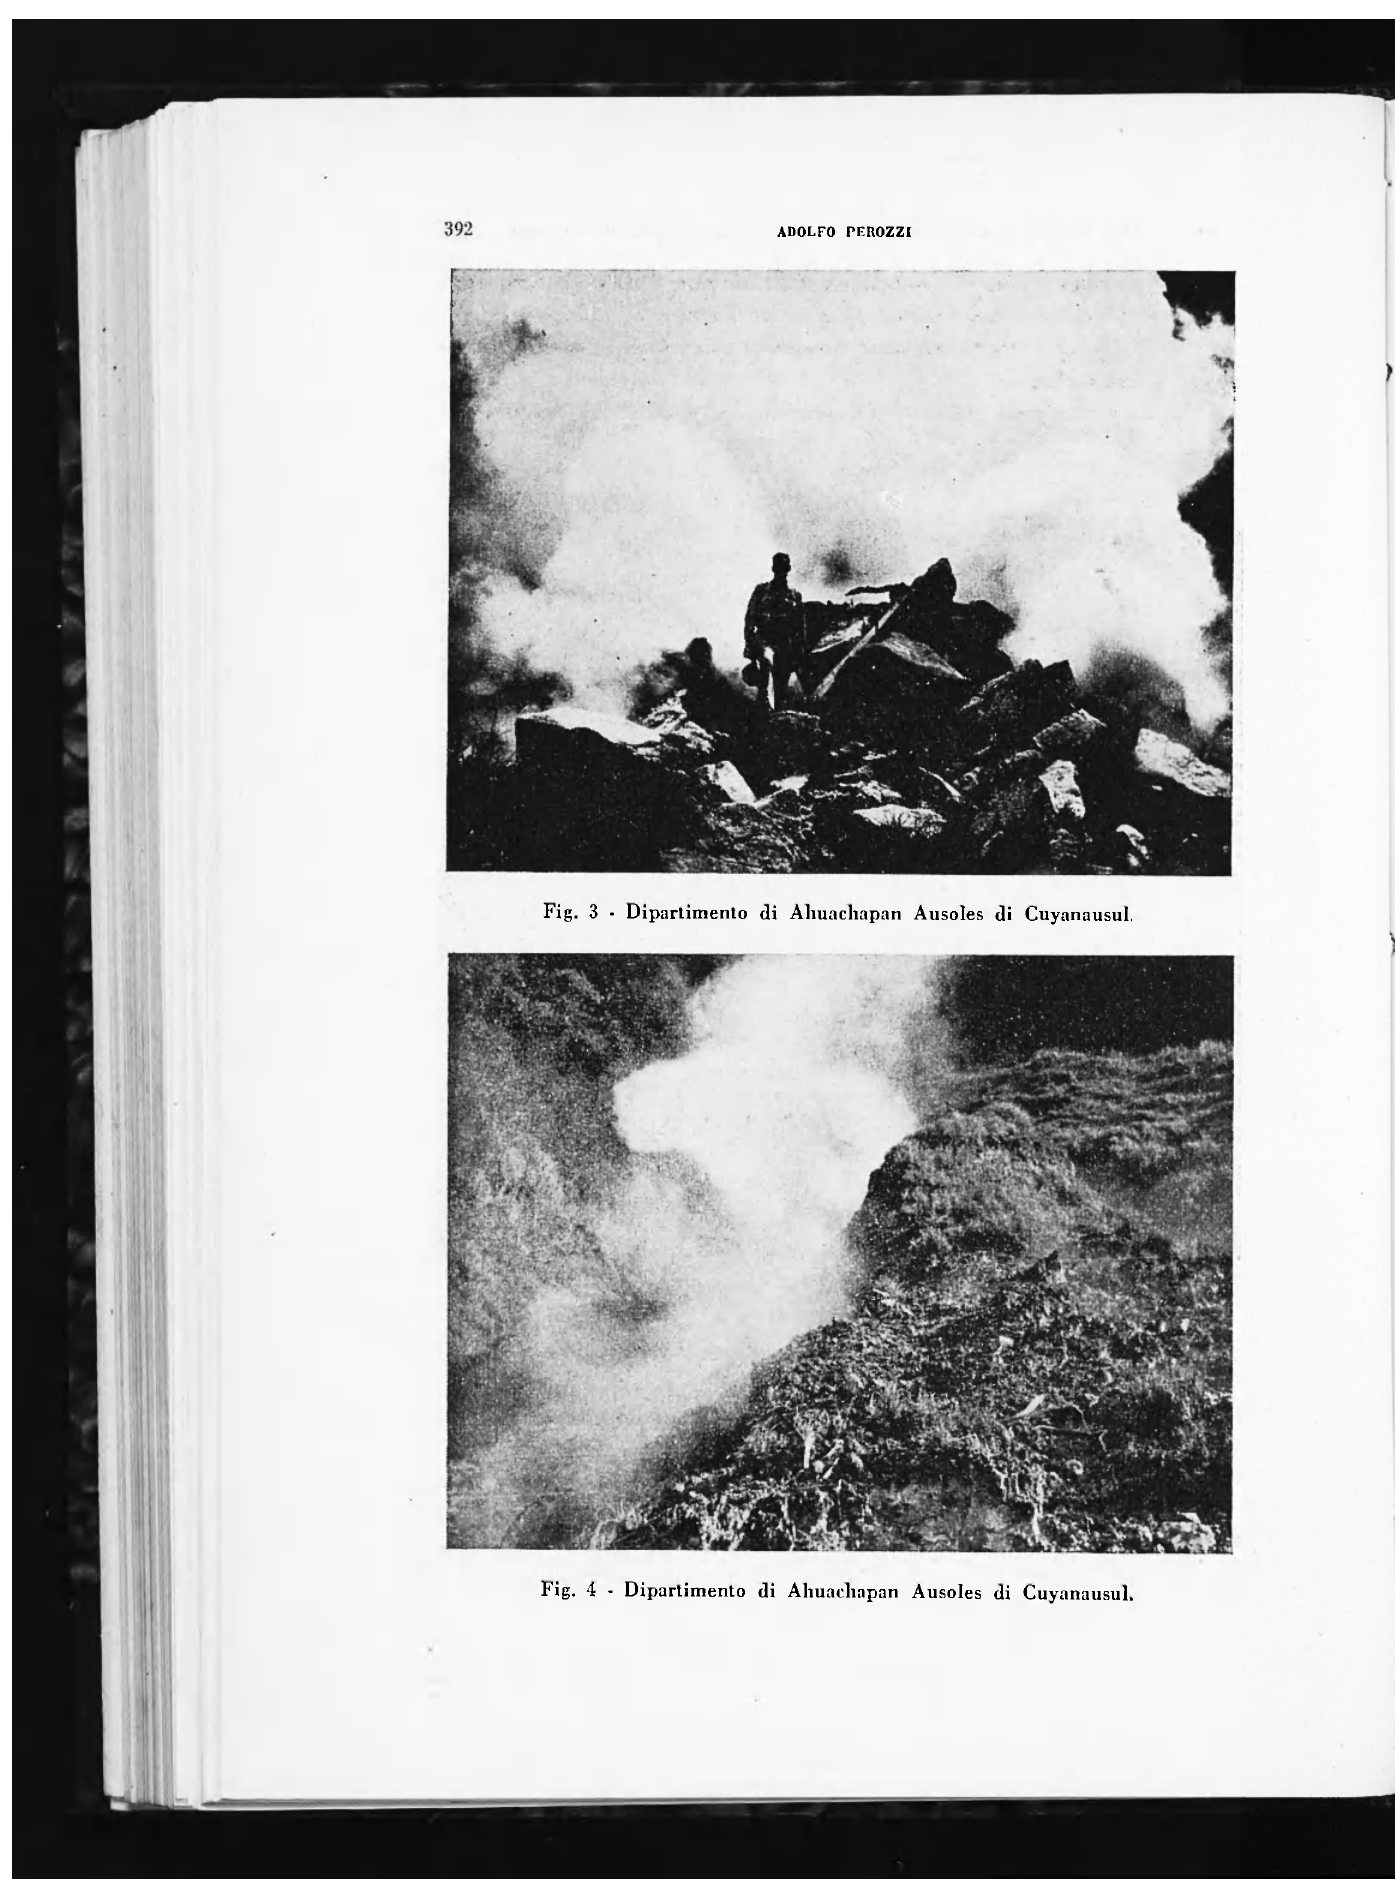
Fig. 4 - Dipartimento di Ahuachapan Ausoles di